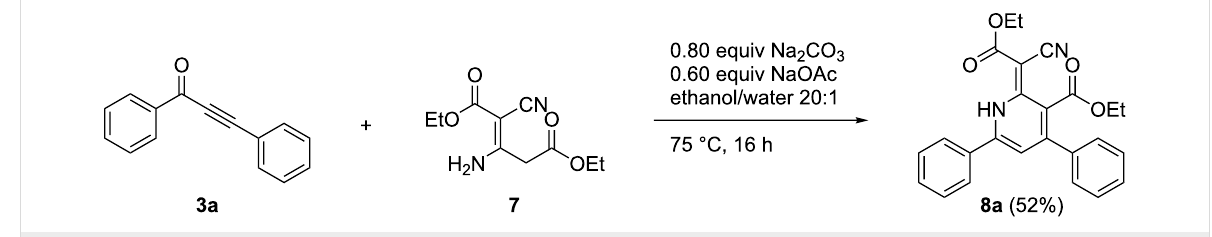
Table 3: Influence of the reaction time on the self-condensation of ethyl cyanoacetate ( 4 ) in the presence of the optimized base system. a